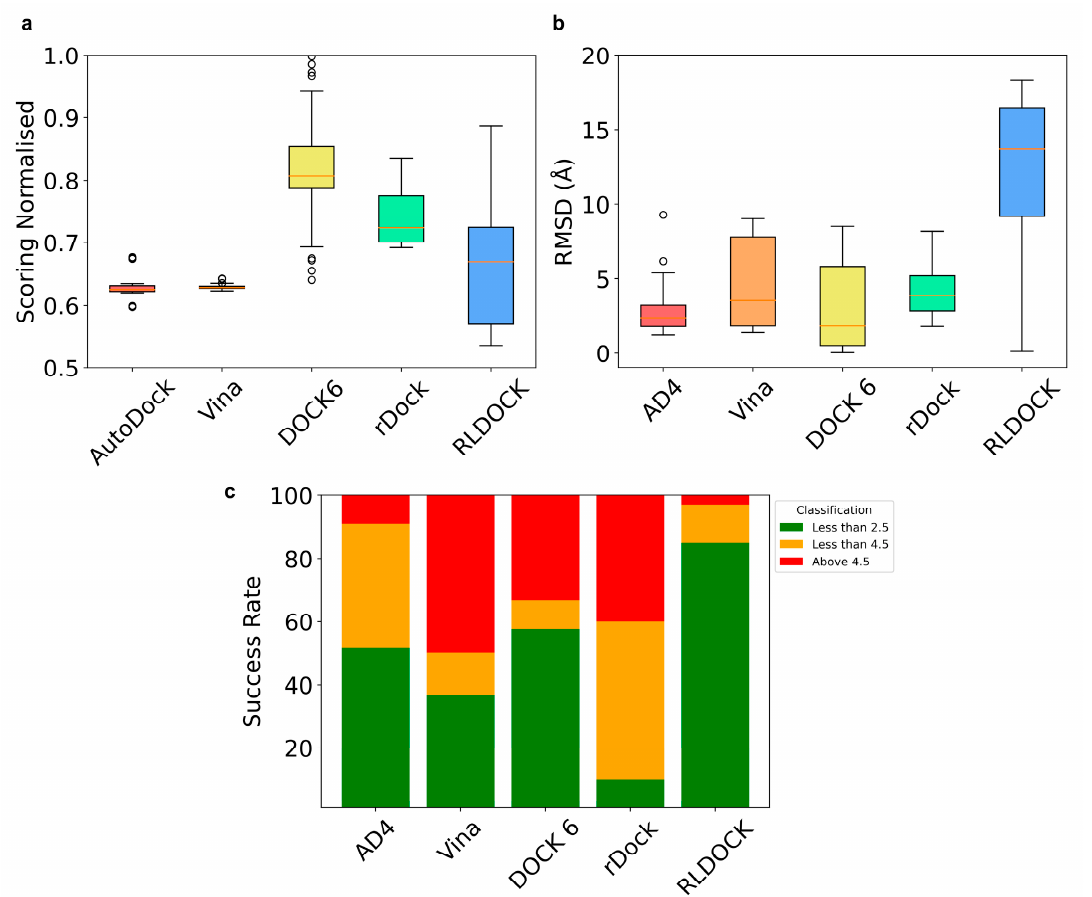
Figure 4. The five selected docking programs used to validate crystal structures using the top- performing values from each crystal structure. Each docking program was ranked by scoring ( a ) and RMSD ( b ). Each program’s overall success rate was used to calculate the average using the normalized top-scoring poses of each program. Both graphs display the minimum and maximum values, with the median values indicated with the orange line and the circles being the outliers. ( c ) A stacked bar chart demonstrating each selected program’s success rate is shown. The green, yellow, and red areas correspond to the percentage of models that achieve an RMSD of ≤ 2.5, ≤ 4.5, and >4.5 Å,